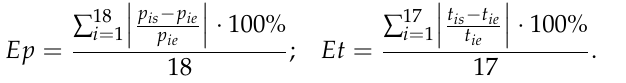
Figure 7. Selected results of pressures histories for Case 02 ( Re = 2750): ( a ) initial phase; ( b ) later phase.